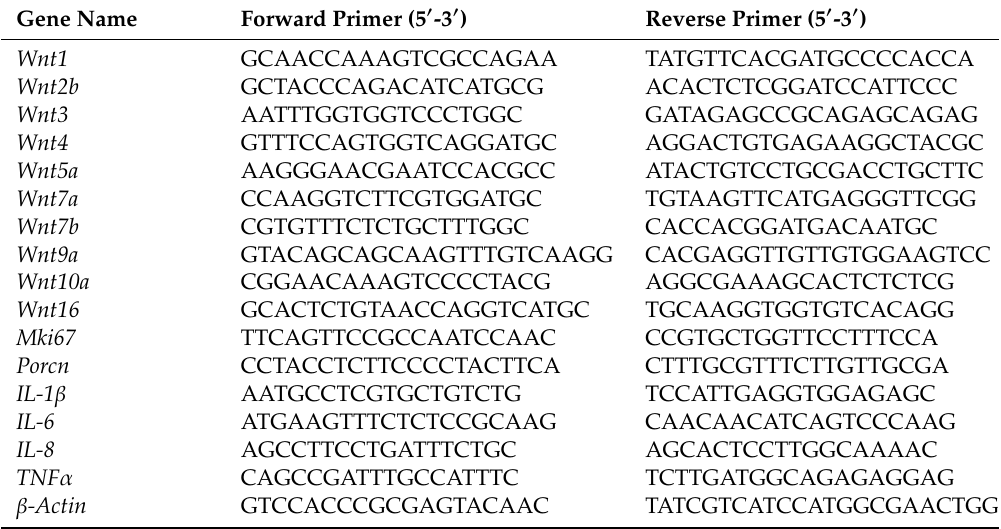
Table 1. Primer pairs for